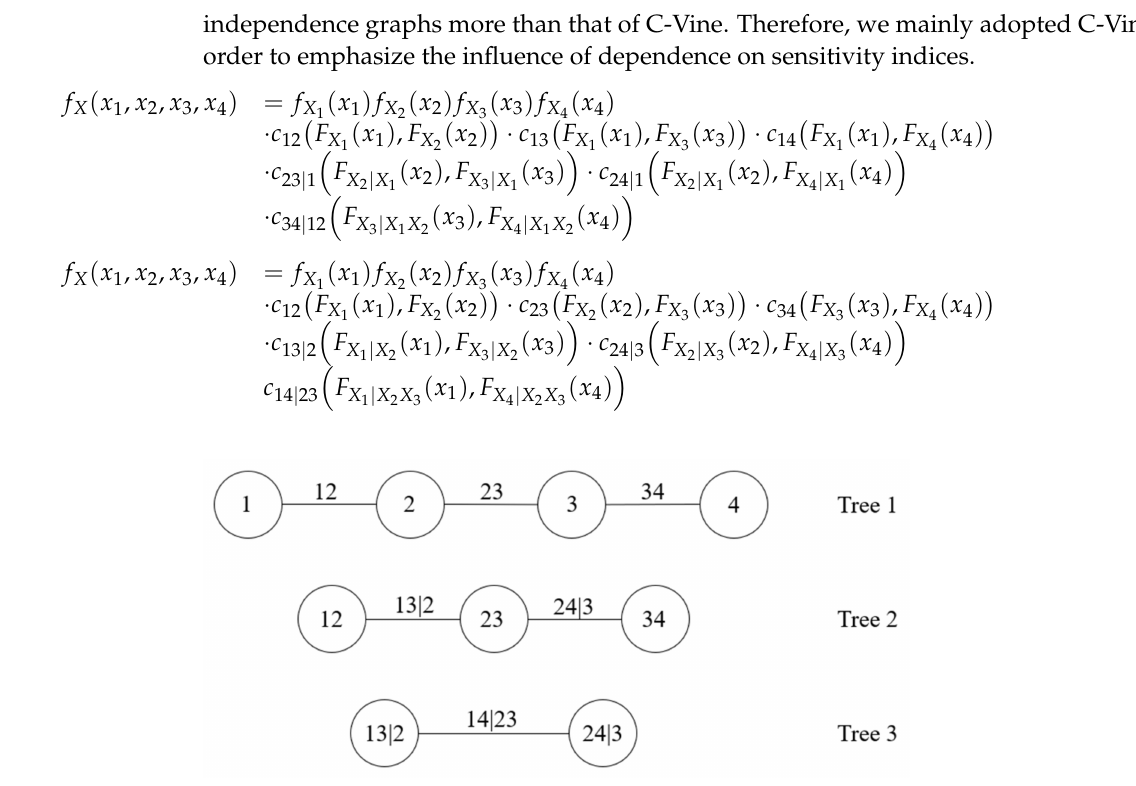
Figure 2. D-Vine model of four-dimensional variables.